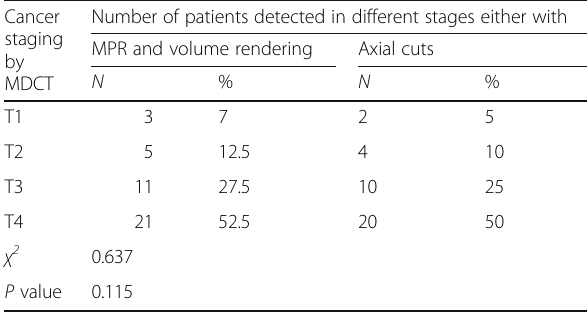
Table 5 The tumor detection rate with MDCT axial cuts, MPR, and VR in different stages Cancer Number of patients detected in different stages either with staging MPR and volume rendering Axial by MDCT